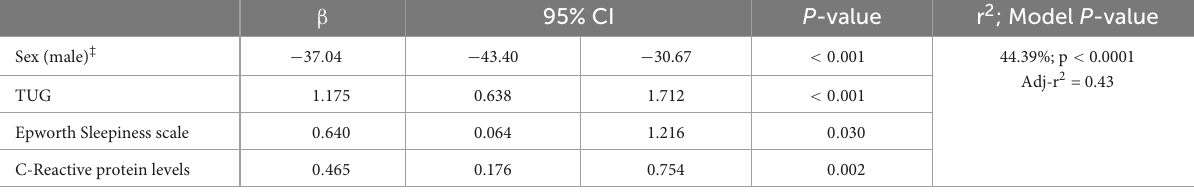
TABLE 4 Best regression model for rectus femoris (RF) corrected (24) echo-intensity prediction. β 95%